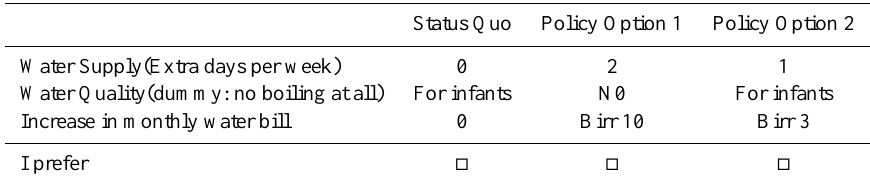
Table 1. An example of choice task.